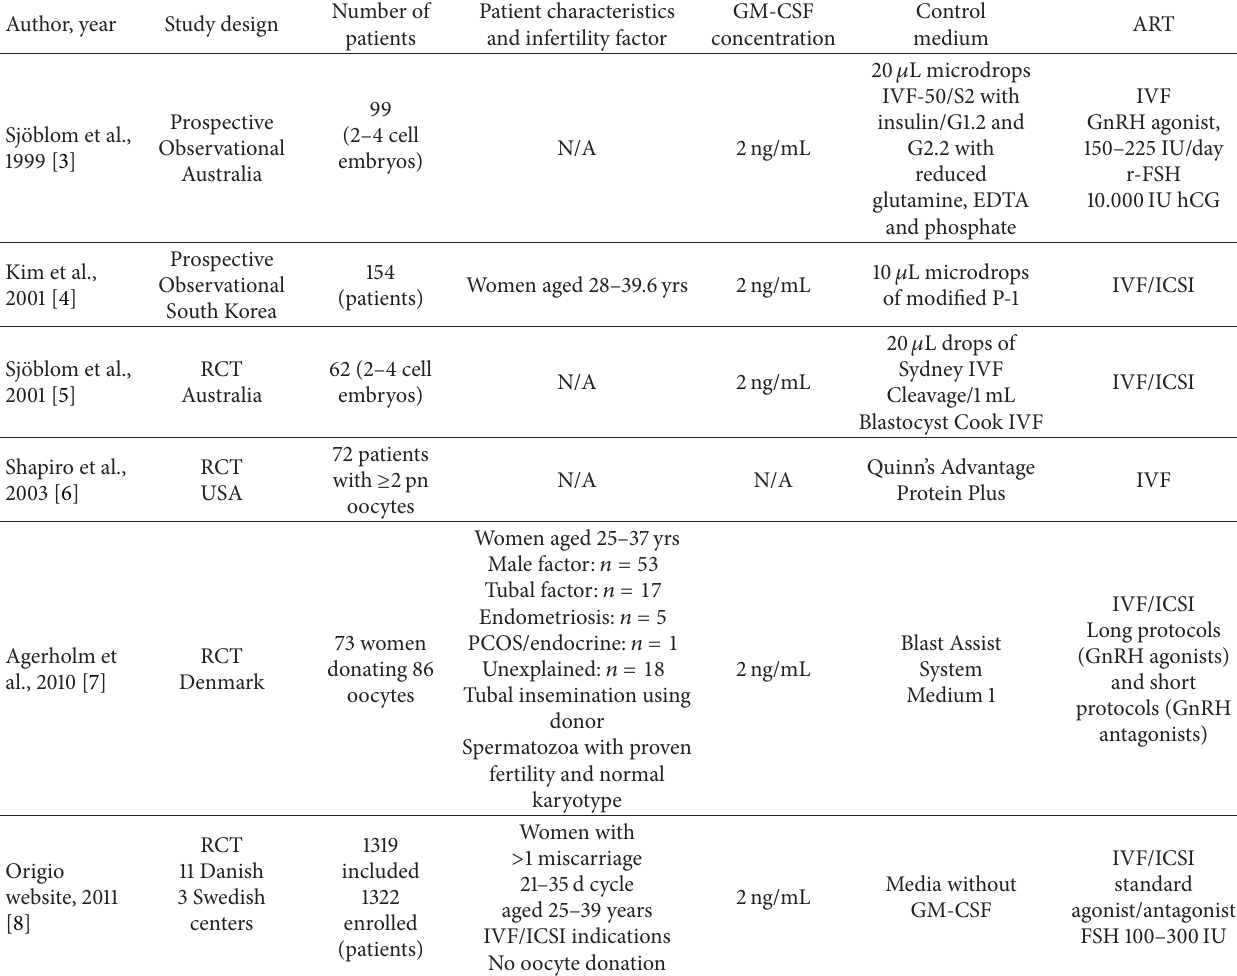
Table 1: Study design parameters and